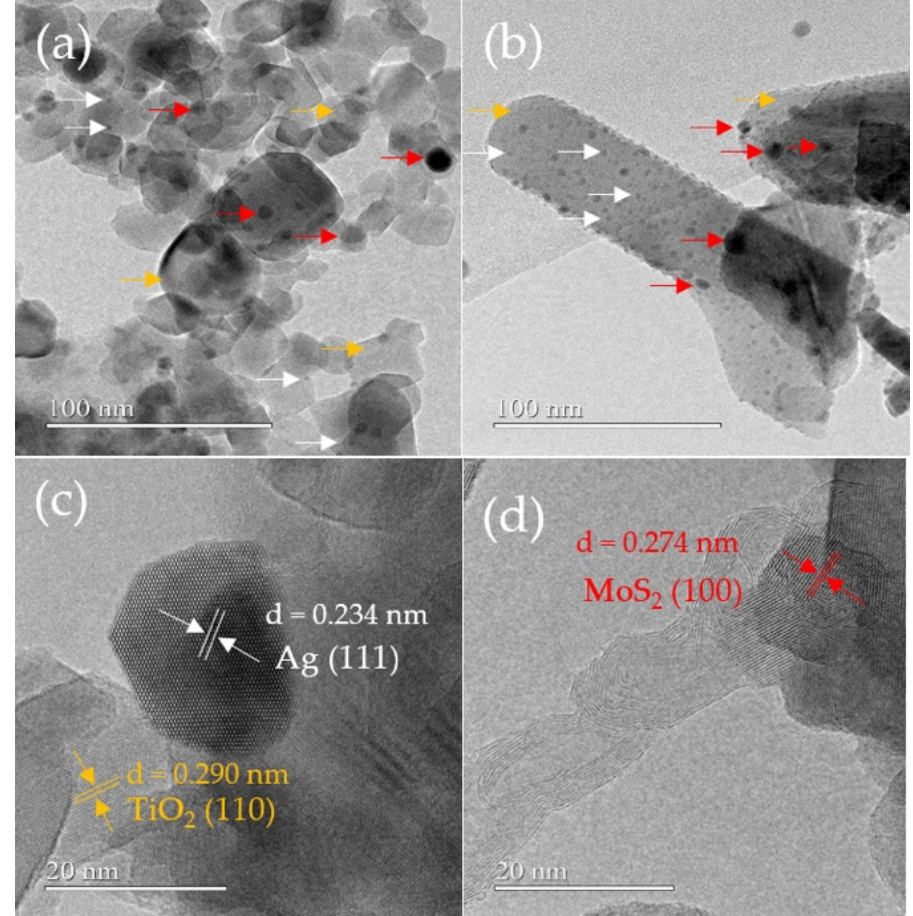
Figure 3. High-resolution transmission electron microscopy (HRTEM) micrographs of 5Ag%TiO 2 - P25-5%MoS 2 ( a ), and 5Ag%TiO 2 NWs-5%MoS 2 ( b ). ( c ) shows a magnification of AgNPs with a lattice spacing of ca. 0.234 nm, and the lattice spacing of the TiO 2 NWs. ( d ) presents the spacing lattice of MoS 2 . The white, red, and yellow arrows show the AgNPs, MoS 2 , and TiO 2 , respectively. The catalysts were also characterized by X-ray photoelectron spectroscopy